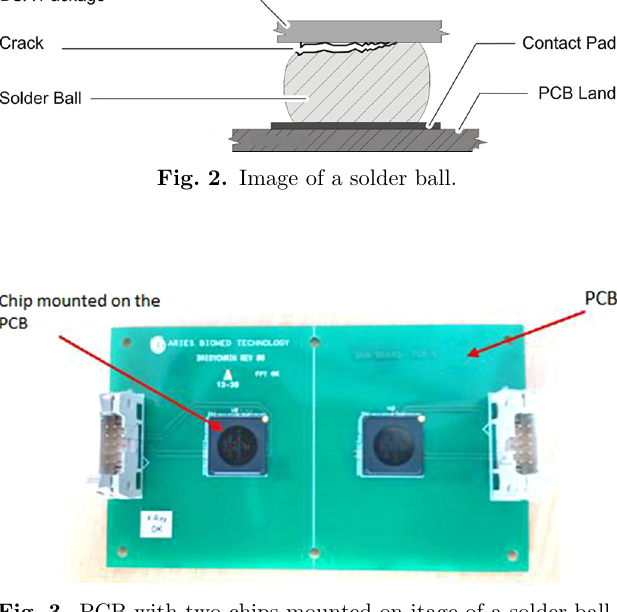
Fig. 3. PCB with two chips mounted on itage of a solder